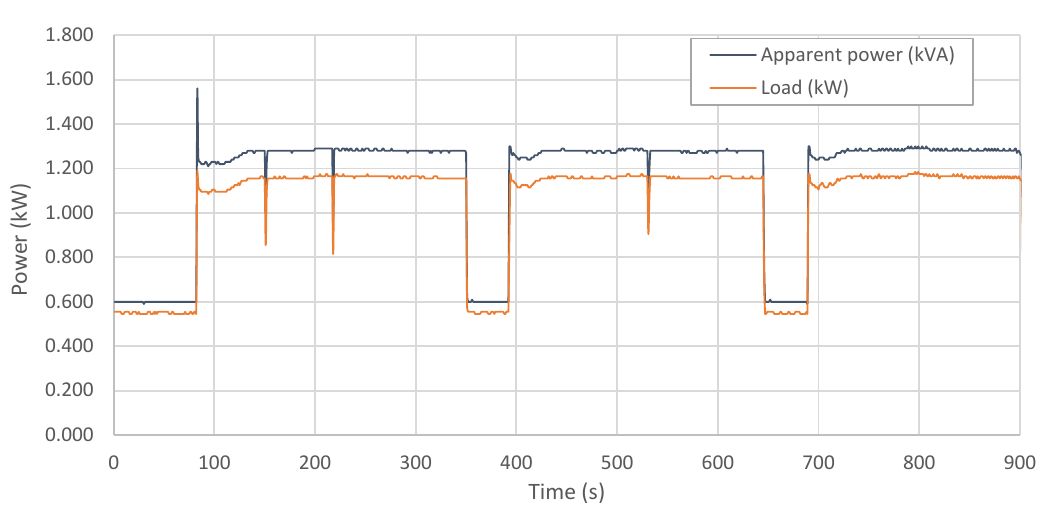
Figure 4. Total cooling system load levels for laser running at 120 W.